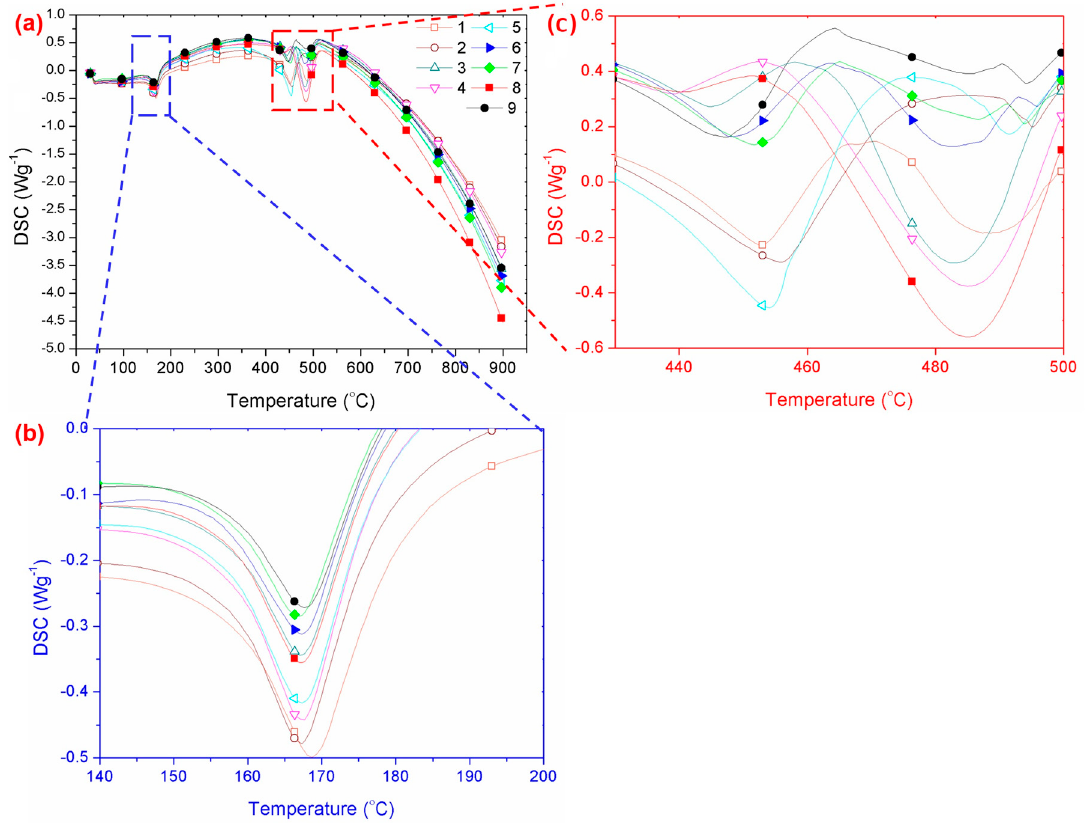
Figure 4. ( a ) Di ff erential scanning calorimetry (DSC) curve of PP / MCF / xGNP / SG composite, Figure 4. ( a ) Differential scanning calorimetry (DSC) curve of PP/MCF/xGNP/SG composite, as as temperature reached 900 ◦ C, ( b ) enlargement of ( a ) at temperatures ranging between 140 ◦ C temperature reached 900 °C, ( b ) enlargement of Figure 4( a ) at temperatures ranging between 140 °C Polymers 2019 , 11 , x FOR PEER REVIEW 8 of 12 to 200 ◦ C, and ( c ) enlargement of ( a ) at temperatures ranging from 430 ◦ C to 500 ◦ C. to 200 °C, and ( c ) enlargement of Figure 4 ( a ) at temperatures ranging from 430 °C to 500 °C.